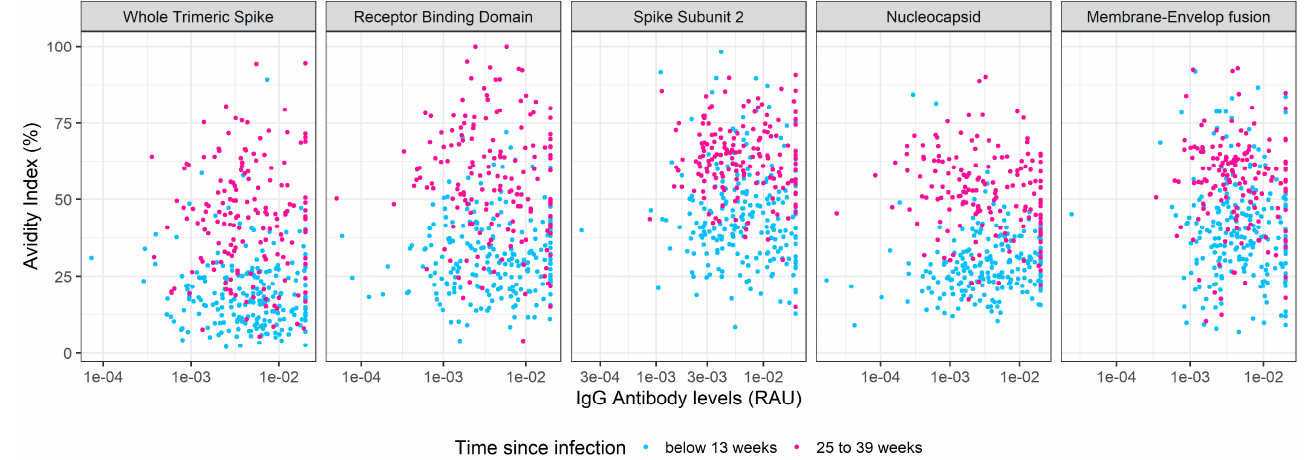
Figure 3. Serological markers of time since infection. Anti-SARS-CoV-2 IgG levels and avidity were measured in samples from individuals with recent (within the previous 3 months, red) and older (6–9 months ago, blue) naturally acquired SARS-CoV-2 infection.